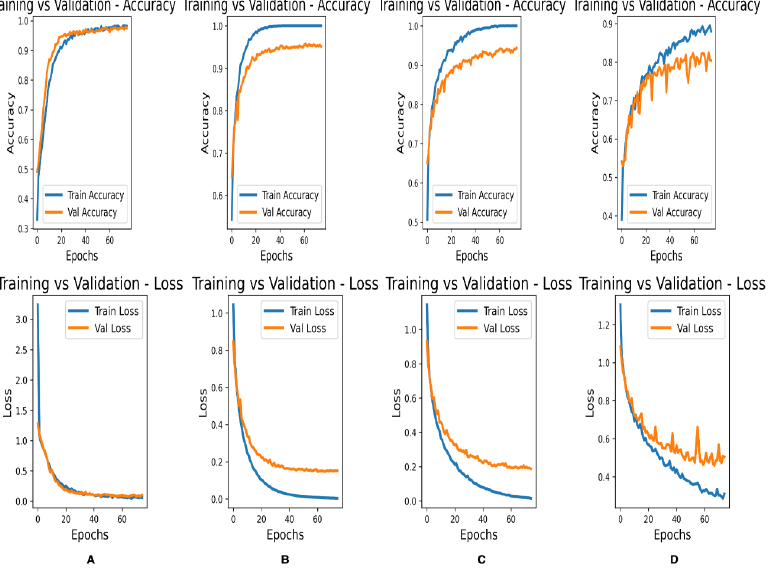
Figure 3. Accuracy and loss curves for training and validation of the second data-fold for various CNN architectures. ( A ) Fet-Net architecture. ( B ) VGG-16. ( C ) VGG19. ( D ) ResNet-50.